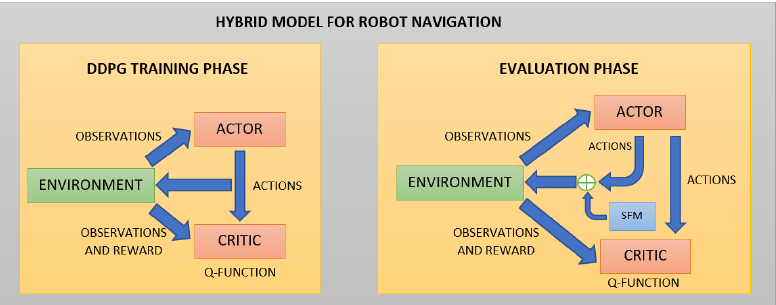
Figure 2. Hybrid Model Scheme. The model is trained using the DDPG algorithm without SFM actions. Once the model is trained in the evaluation phase, the SFM actions are added to move the robot in the